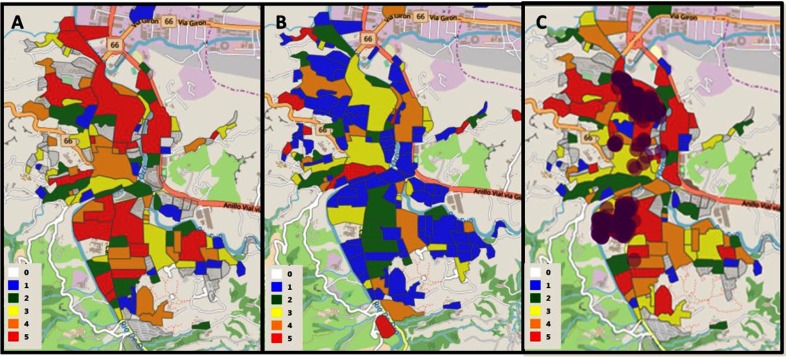
Epidemiological (A) and Entomological (B) Dengue Risk Maps and (C) Location of Positive Catch Basinsa in Giron Neighborhoods, Colombia, January 1, 2014–December 31, 2016aIndicated by purple dots over the epidemiological risk map.Risk stratification in the maps is classified in quintiles, with 1 (blue) being the lowest risk and 5 (red) being the highest, during the observed period. 0 (white) indicates missing data.